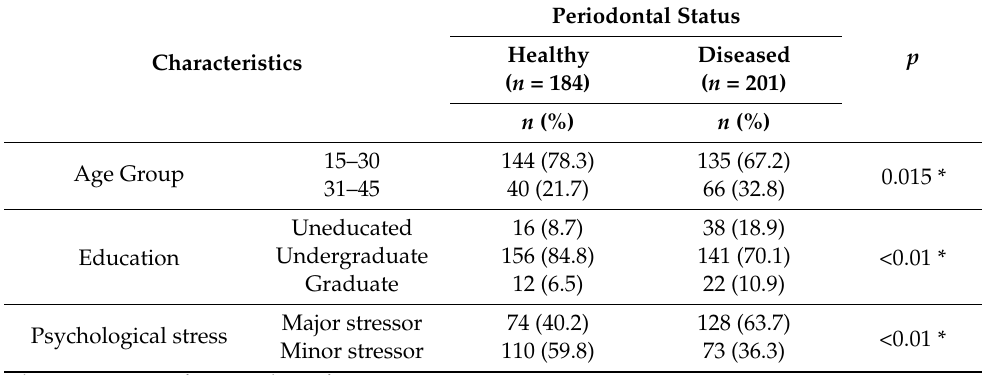
Table 2. Periodontal status by age group, education, and psychological